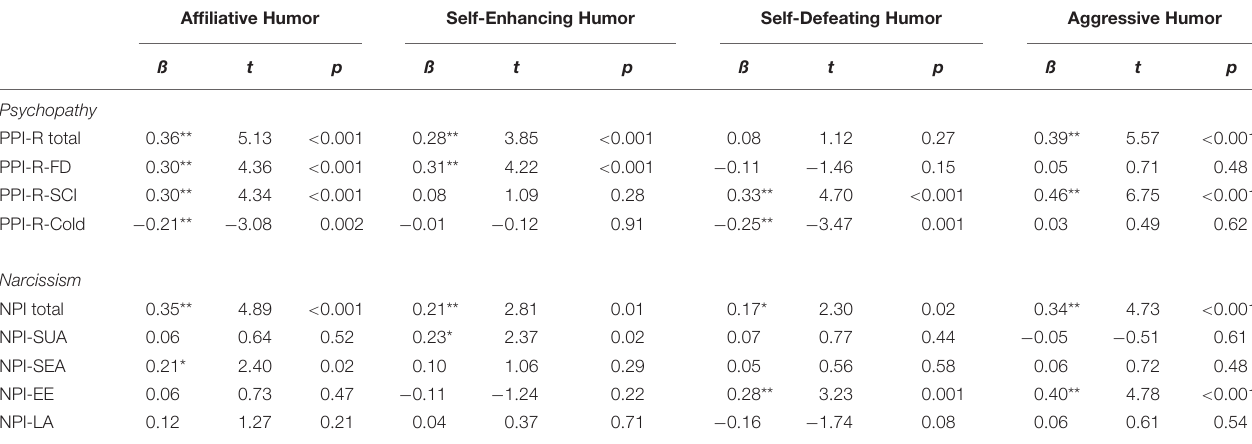
TABLE 2 | Results of the four sets of multiple regression analyses with humor styles as dependent variables, and separately psychopathy total, narcissism total, psychopathy subscales, and narcissism subscales as independent variables ( N = 177). Affiliative Humor Self-Enhancing Humor Self-Defeating Humor Aggressive